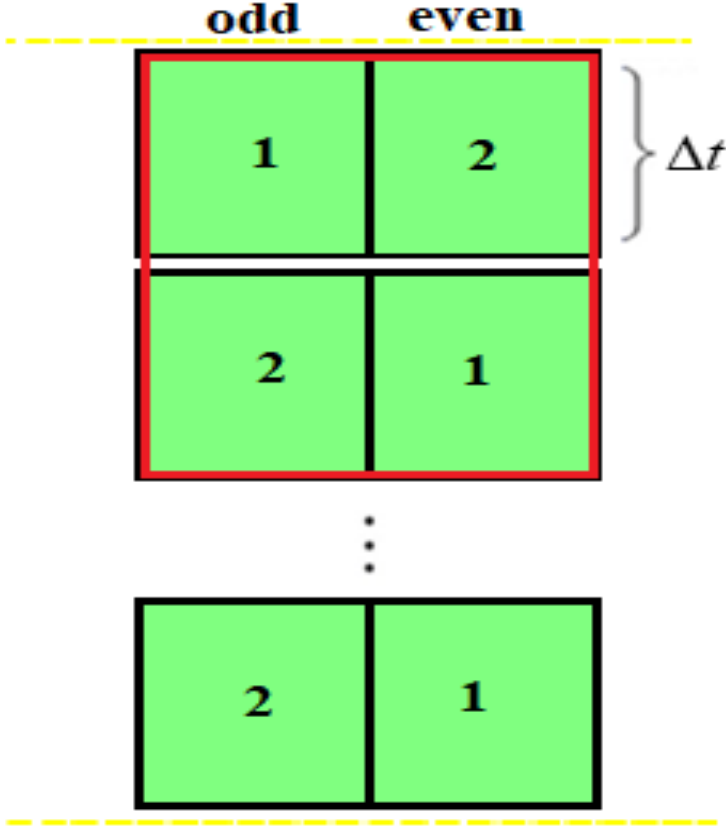
Figure 3. Space-time structure of the hopscotch (OOEH)